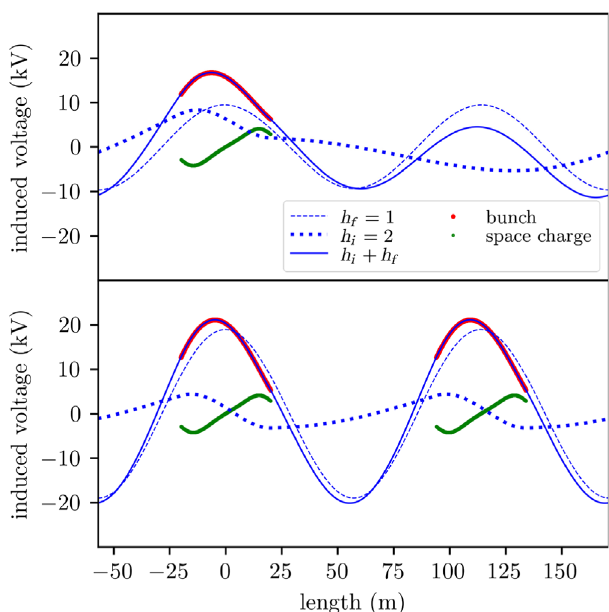
FIG. 6. The bucket trajectories (dashed line) and bunch boundaries (solid line) without space charge and beam loading (in black); matched to space charge (in blue); matched to beam loading (in green); and matched to both space charge and beam loading (in red), calculated via using iteration scheme from the ¼ 1 generalized elliptical bunch model. The two points in black and in f red denote the centers of the two buckets without and with beam loading,